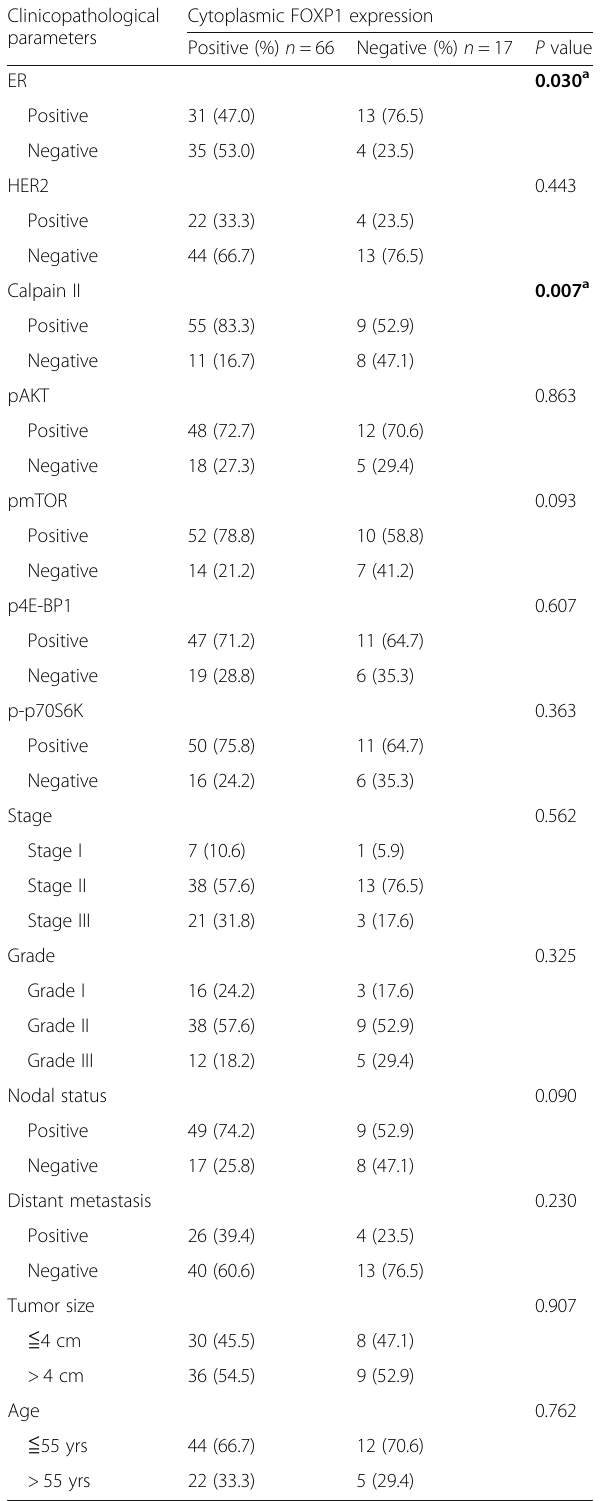
Table 2 The correlation between cytoplasmic FOXP1 expression and clinicopathological parameters in IDC cases Clinicopathological parameters